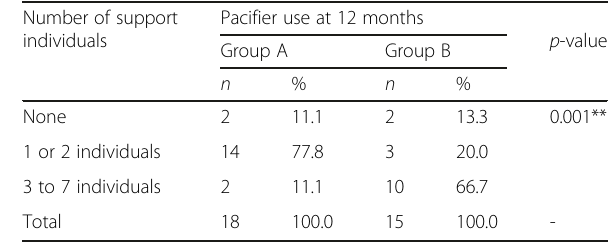
Table 4 The distribution of participants based on the number of individuals who were able to help care for the infant